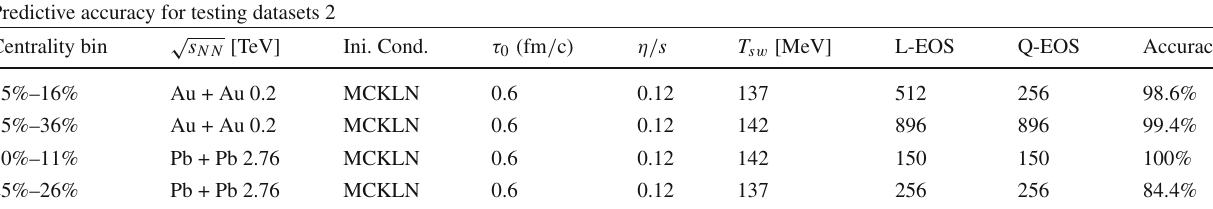
Table 5 Predictive accuracy on the testing datasets 2: 30-events-fine-averaged spectra ρ a ( p T ,(cid:6)) generated with MCKLN initial conditions and √ s NN , η/ s , τ 0 , and T s w in the centrality range 0–40% the different Predictive accuracy for testing datasets 2